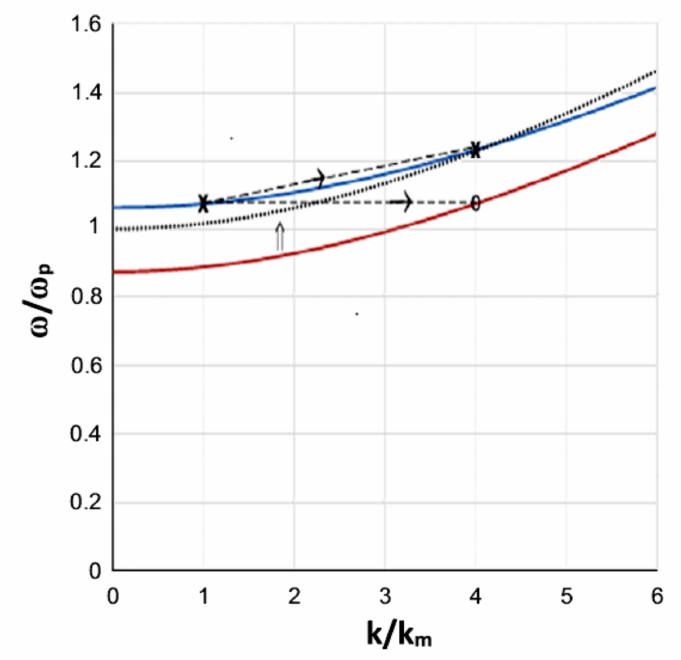
Figure 13. Mode conversion as the upper hybrid wave (the crossing point x on the blue curve) propagates down to becoming a parallel propagating Langmuir wave (the circle o on the red curve) in the artificial ionization layers (AIL)